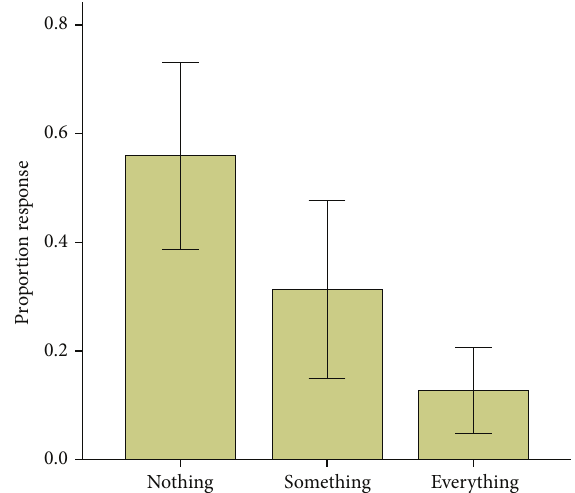
Figure 3: Proportion response to each of the three alternatives aver- aged across participants. The error bars represent 95% confidence interval.